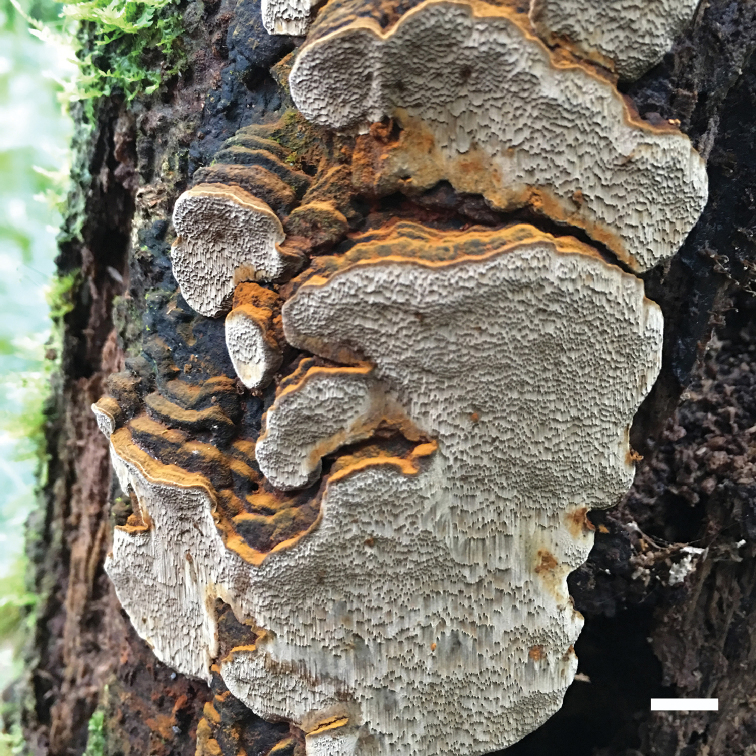
Basidiomata of Fomitiporella
vietnamensis. Scale bar: 1 cm.